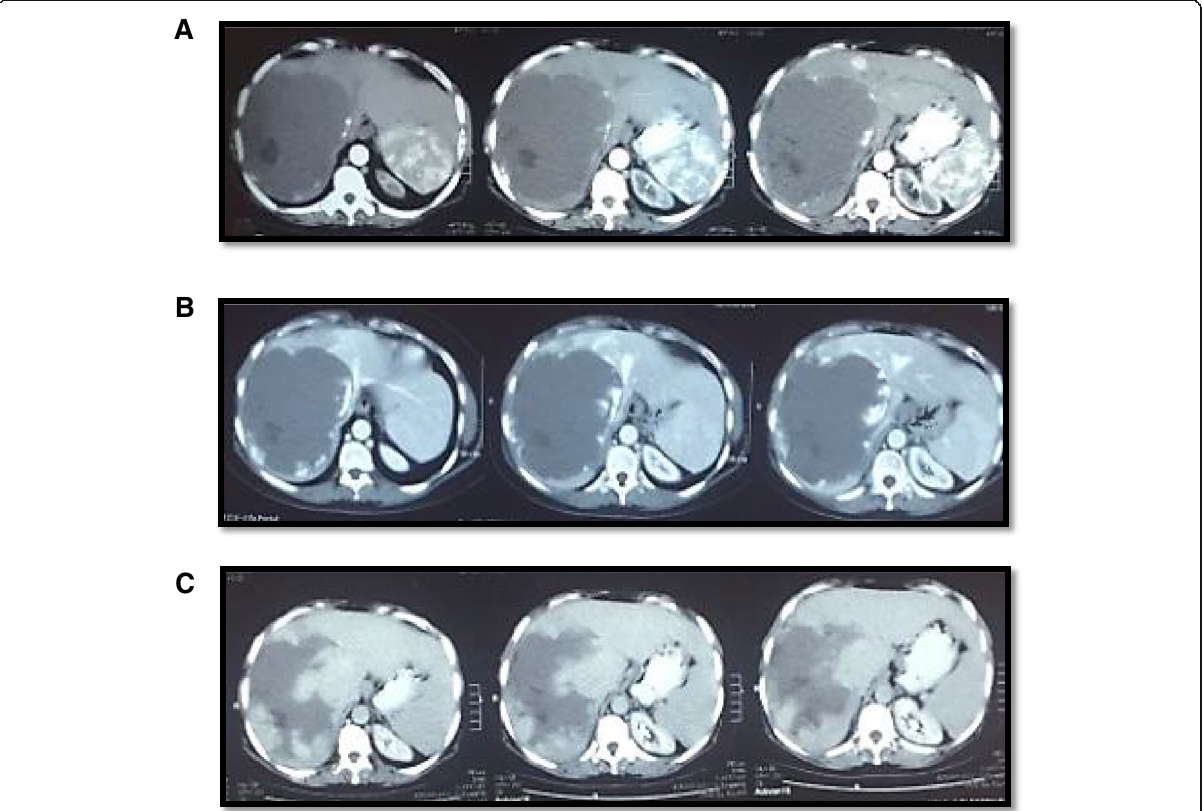
Fig. 2 Large right hepatic lobe hemangioma as seen by triphasic CT. a Arterial phase showing faint peripheral enhancement of the lesion. b Porto-venous phase showing more pronounced peripheral nodular enhancement by the lesion. c Delayed images showing progressive contrast enhancement toward the center of the lesion